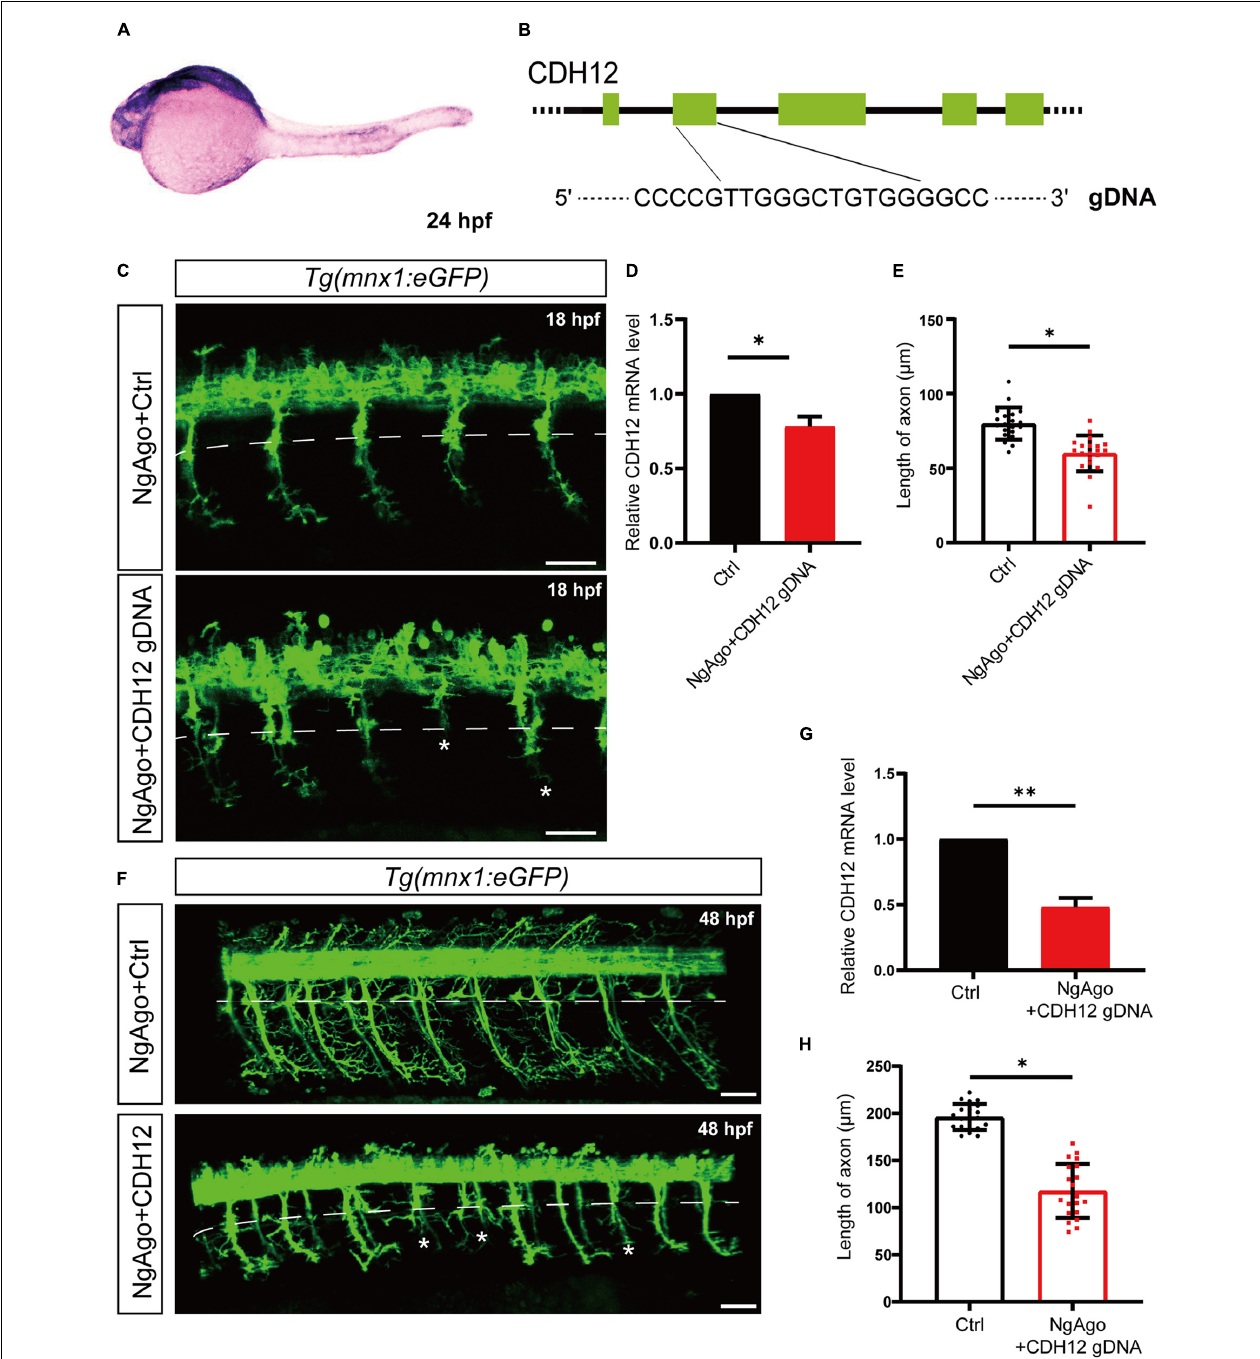
FIGURE 5 | Knockdown of CDH12 shortens the length of axons in zebrafish caudal primary (Cap) neurons. (A) In situ hybridization showing the expression patterns of CDH12 in zebrafish embryos at 24 hpf. CDH12 expression is mainly observed in the hindbrain and the spinal cord. (B) Schematic diagram of CDH12 gDNA-induced NgAgo knockdown. (C) Fluorescence images of Cap neurons after NgAgo-mediated CDH12 knockdown for 18 h. White dotted lines indicate the body parts of zebrafish Cap neurons, and a “ ∗ ” represents the absence of axons. The scale bar represents 50 µ m. (D) The efficiency of CDH12 NgAgo treatment as determined via the qRT-PCR assay. The data are presented as the mean ± SE, n = 3, ∗ P < 0.05. (E) Statistical results of the axon length of Cap neurons after CDH12 knockdown in zebrafish embryos for 12 h. The data are presented as the mean ± SE, n = 20, ∗ P < 0.05. (F) Fluorescence images of NgAgo-mediated CDH12 knockdown in zebrafish (HB9) for 48 h. The scale bar represents 50 µ m. (G) The knockdown efficiency carried out by NgAgo treatment was further improved. The data are presented as the mean ± SE, n = 3, ∗∗ P < 0.01. (H) The extension of axons was similarly inhibited by CDH12 knockdown for 48 h. The data are presented as the mean ± SE, n = 20, ∗ P <